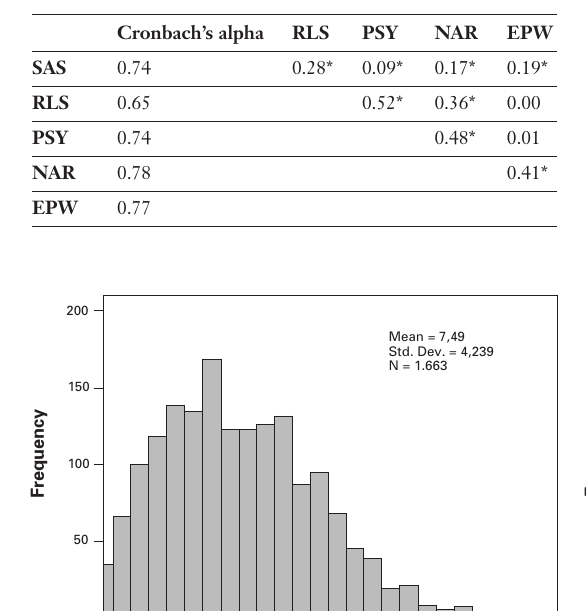
Table 1 Raw Scores Percentage of respondents with elevated scores Prevalence of sleep disorder symptoms and daytime sleepi- ness in 4901 ques- tionnaire respon- dents (3238 females, 1663 males). Data are medians, interquar- tile ranges (IQR), and prevalence. *P <0.001 males vsfemales. Raw score cut-off values sleep disor- ders questionnaire (7): SAS (sleep ap- noea syndrome) females = 32, males = 36; PSY (psychiatric sleep disorders) fe- males = 21, males = Results 19; RLS (restless legs and periodic limb movement disorder) females and males = 21; NAR (narcolepsy) Of 4915 questionnaires submitted to the cen- tral database, 14 were incomplete or contained non-plausible data. Thus, 4901 questionnaires were available for analysis. Corresponding partic- ipants included 3238 (66.1%) females with a mean (±SD) age of 52.4 (±18.1) years, a body mass index of 23.8 (±4.3 kg/m 2 ), and a neck circumference of 34.6 (±3.1 cm). The mean age of the 1663 partici- pating males was 55.1 (±17.1) years, body mass index was 25.7 (±3.9 kg/m 2 ), and neck circumfer- ence was 40.6 (±2.9 cm). Seventy-six percent of the participants were German speaking, 16% French speaking, and 8% Italian speaking. Fifty-six per- cent had a professional employment, 33% were retired, 7% were shift workers, including 1% working night shifts, and 4% attended school.